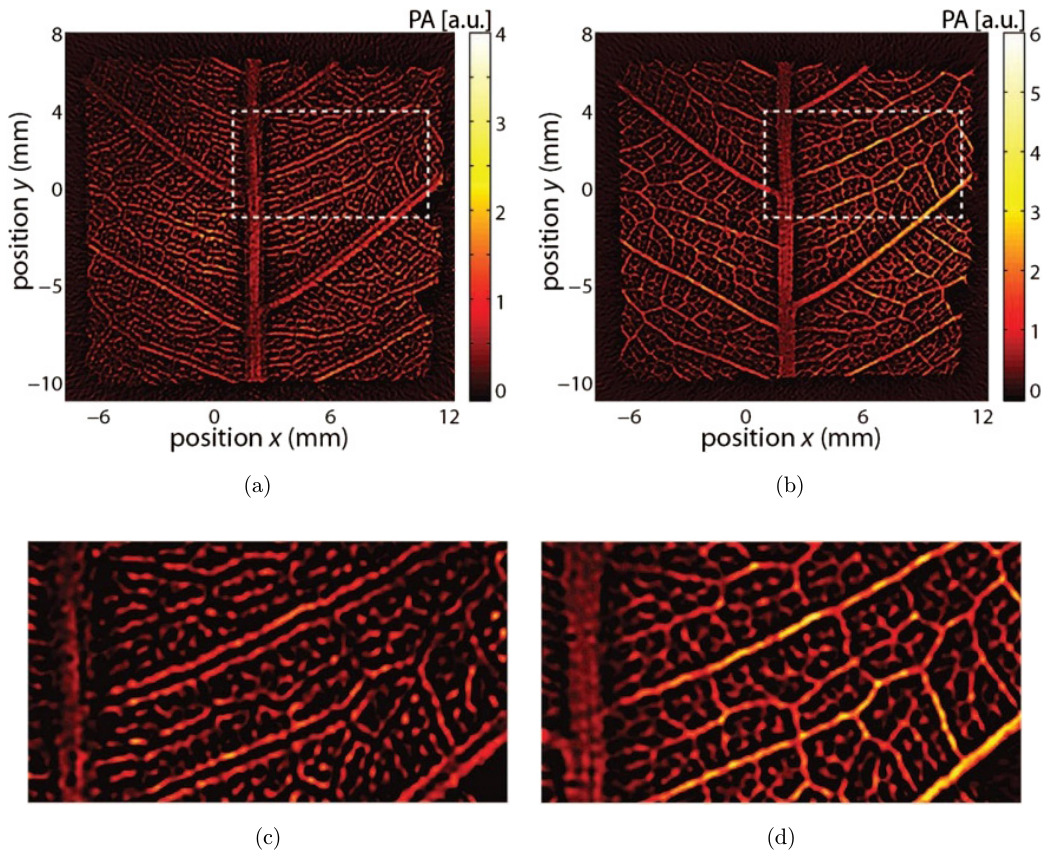
Fig. 1. An example showing how the acoustic heterogeneity may a®ect the ¯nal image quality. (a) PA image of a leaf skeleton reconstructed with a constant SOS of 1506 m/s. (b) PA image of the same leaf skeleton reconstructed with an experimentally measured SOS map. (c) and (d) Corresponding zoomed-in views of the veins in the dashed boxes in (a) and (b). Reproduced with permission from Ref.